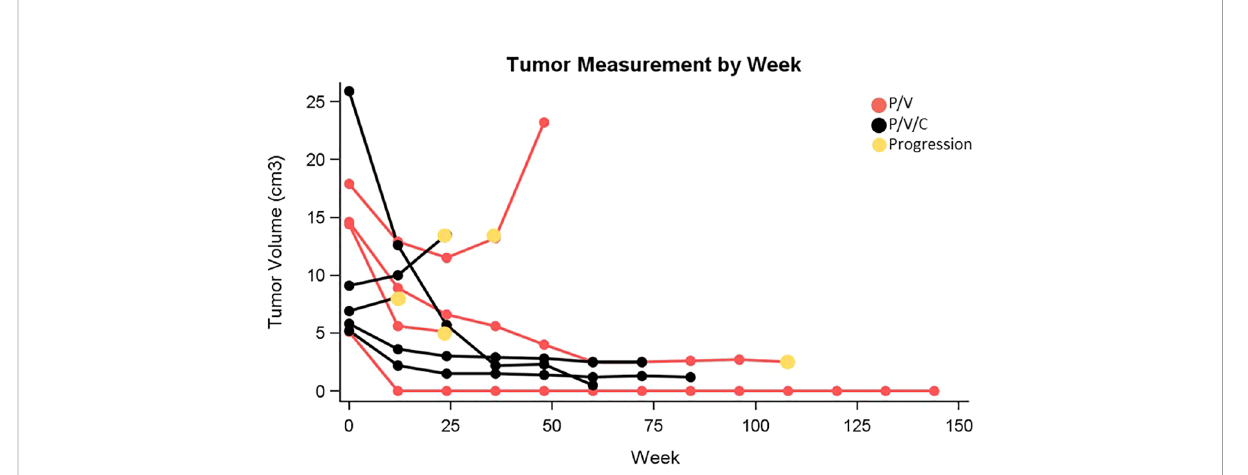
FIGURE 1 Tumor measurement by week (P/V, pembrolizumab/vemurafenib; P/V/C, pembrolizumab/vemurafenib/cobimetinib).